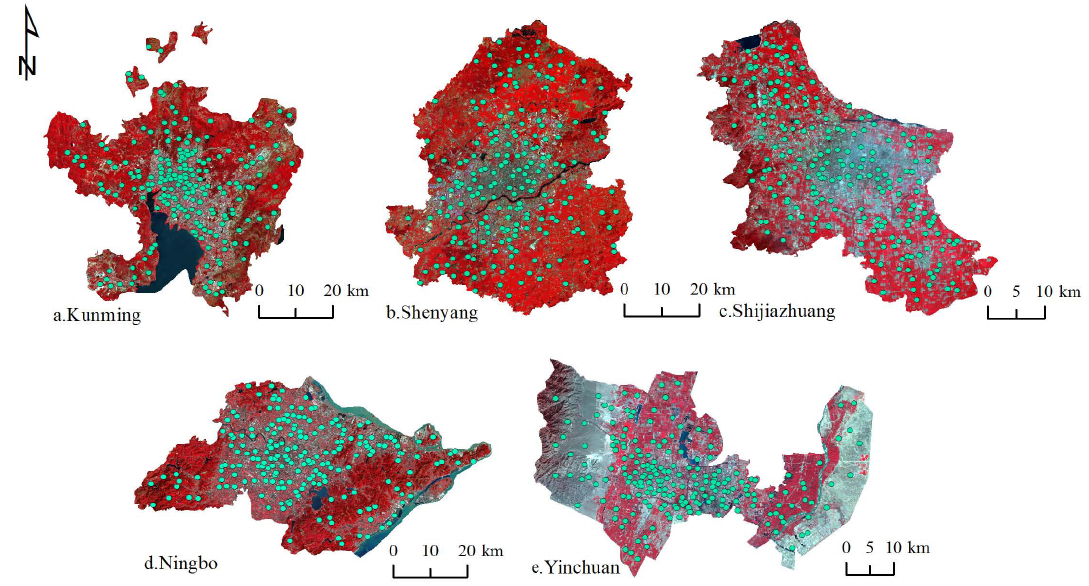
Figure 8. Distribution of samples. Images are displayed in RGB color space, where R, G, and B represent NIR, red, and green,